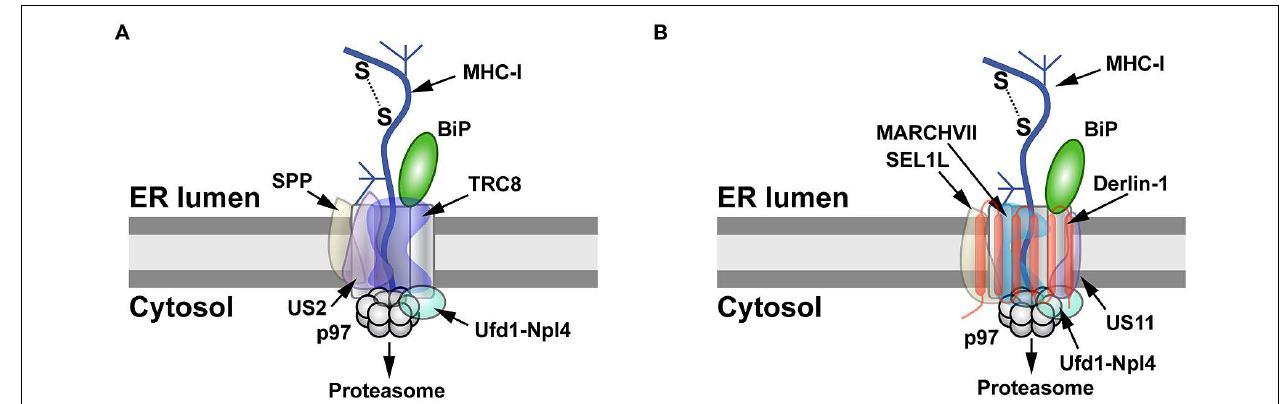
FIGURE 2 | MHC-I degradation by the herpesvirus US2 and US11 proteins. (A) Retrotranslocation of MHC-I by US2. US2 targets MHC-I molecules for retrotranslocation by a process that requires signal peptide peptidase (SPP), the E3 ligase TRC8, and the Ufd1-Npl4-p97 complex. SPP may induce partial degradation of the substrate prior to its proteasomal